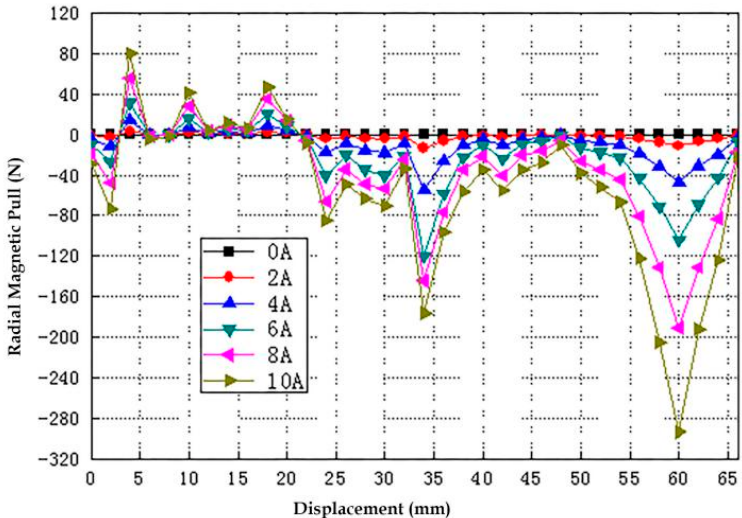
Figure 6. When the winding current is 0 A, 2 A, 4 A, 6 A, 8 A, 10 A, the radial magnetic pull force simulation waveform is shown in Figure 6.